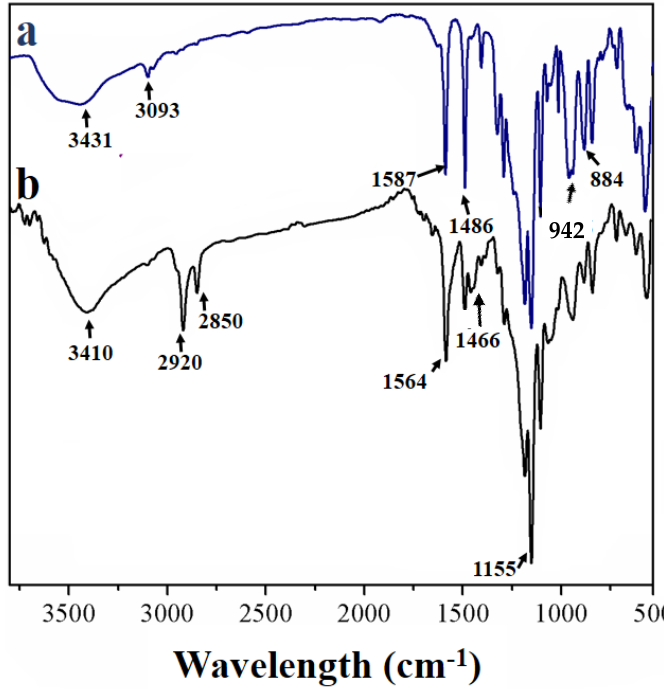
Figure 2. FTIR spectrum of ( a ) PZS and ( b ) PZS@rGO.